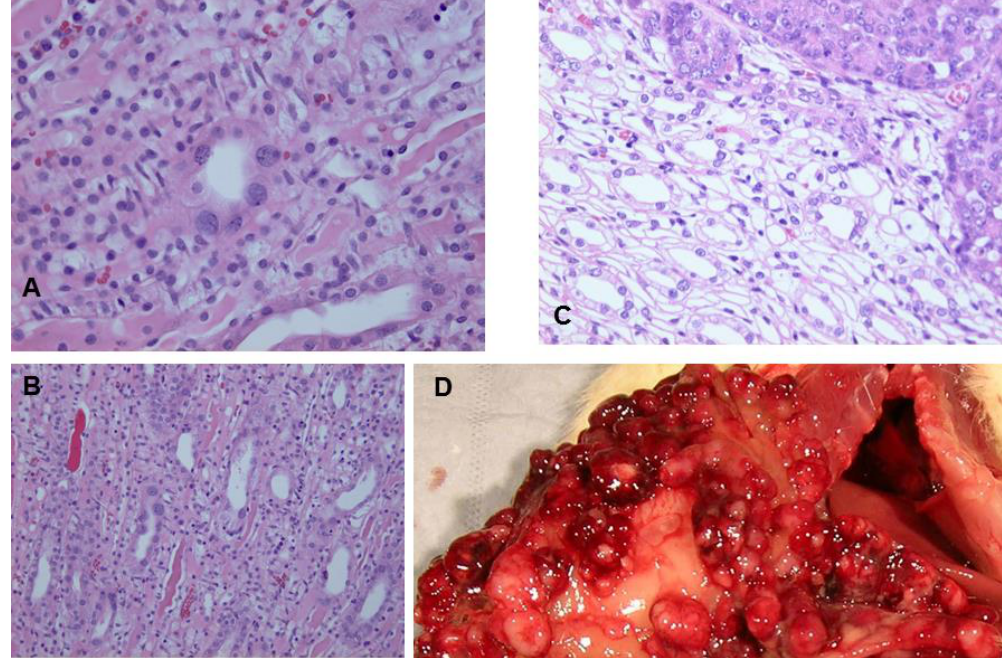
Figure 5. Continuous ochratoxin A. A and B, Hyperplastic renal tubule lesions in transverse and oblique sections with karyocytomegaly. C, Contrasting histology at renal tumour edge. D, Extensive nodules in serosal surfaces in upper abdomen, presumed metastatic from kidney